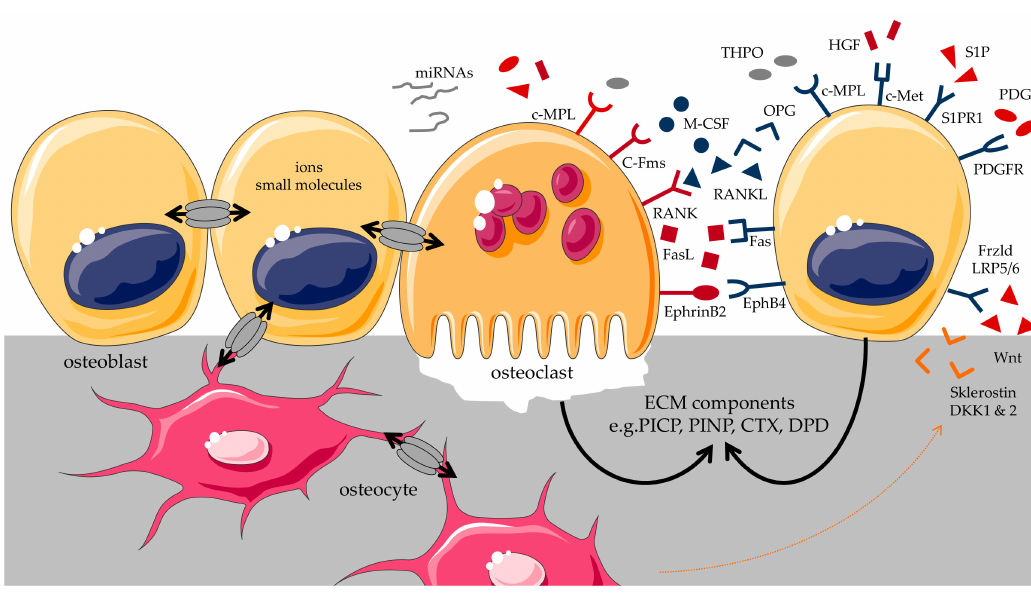
Figure 1. Communication between osteoblast and osteoclast through cell-cell contact (gap junction or EphB4-ephrinB2), paracrine factors (e.g.; M-CSF: macrophage colony stimulating factor, OPG: Osteoprotegerin, RANKL: receptor activator of nuclear factor-kb ligand, THPO: thrombopoietin, S1P: sphingosine-1-phosphate, PDGF: platelet derived growth factor) and their interaction via the bone matrix [21,22,24,26,27,32]. HGF: hepatic growth factor; PICP: procollagen type I carboxy-terminal propeptide; PINP: procollagen type I N-terminal propeptide; CTX: collagen type 1 C-telopeptide; DPD: deoxypyridinoline; DKK1 & 2: dickkopf 1 & 2. Graphical components were obtained from